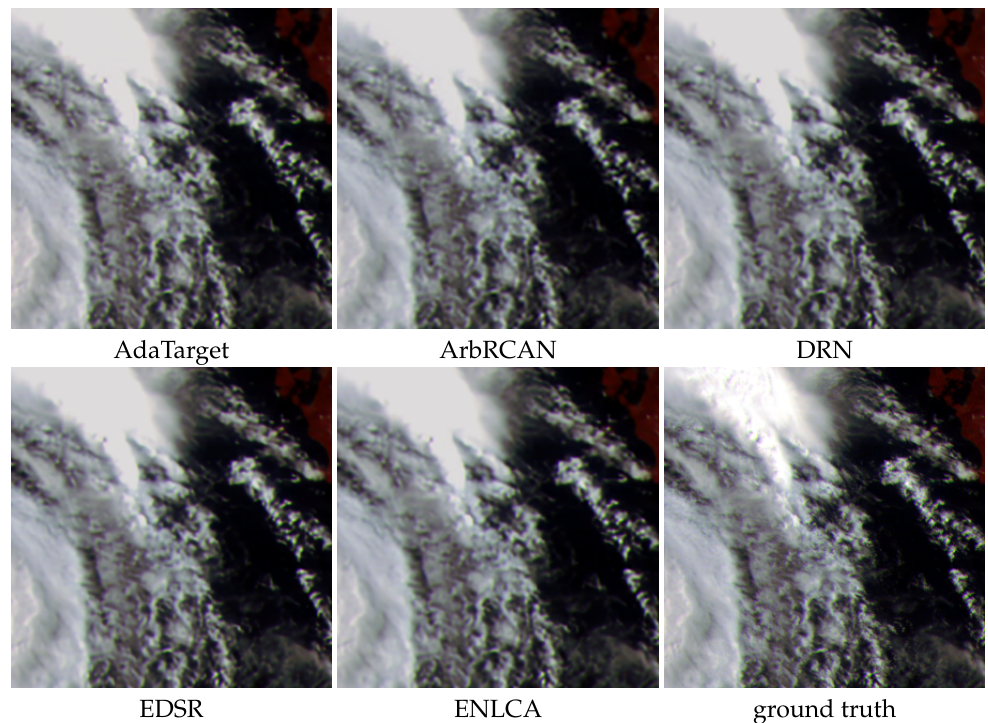
Figure 14. Local manifestation of the super-resolution results on the FY4ASRcolor dataset: Patch 2.